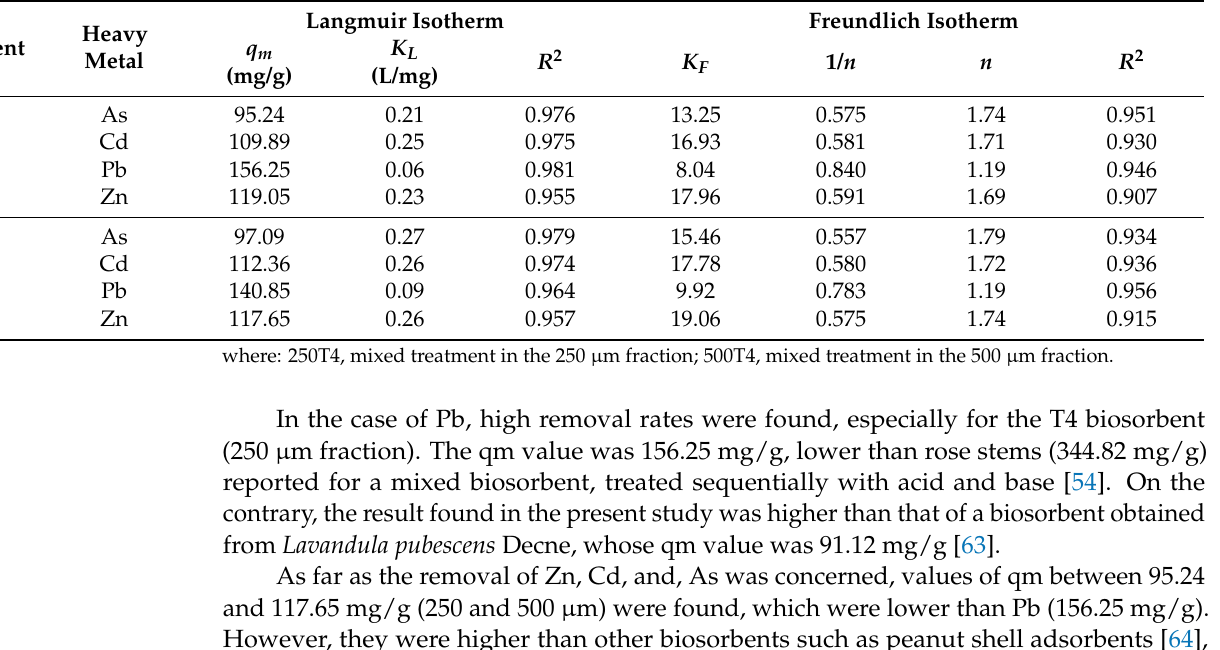
Figure 6. Influence of pH on the removal of heavy metals for the 250 and 500 µm fractions of the mixed treatment T4.